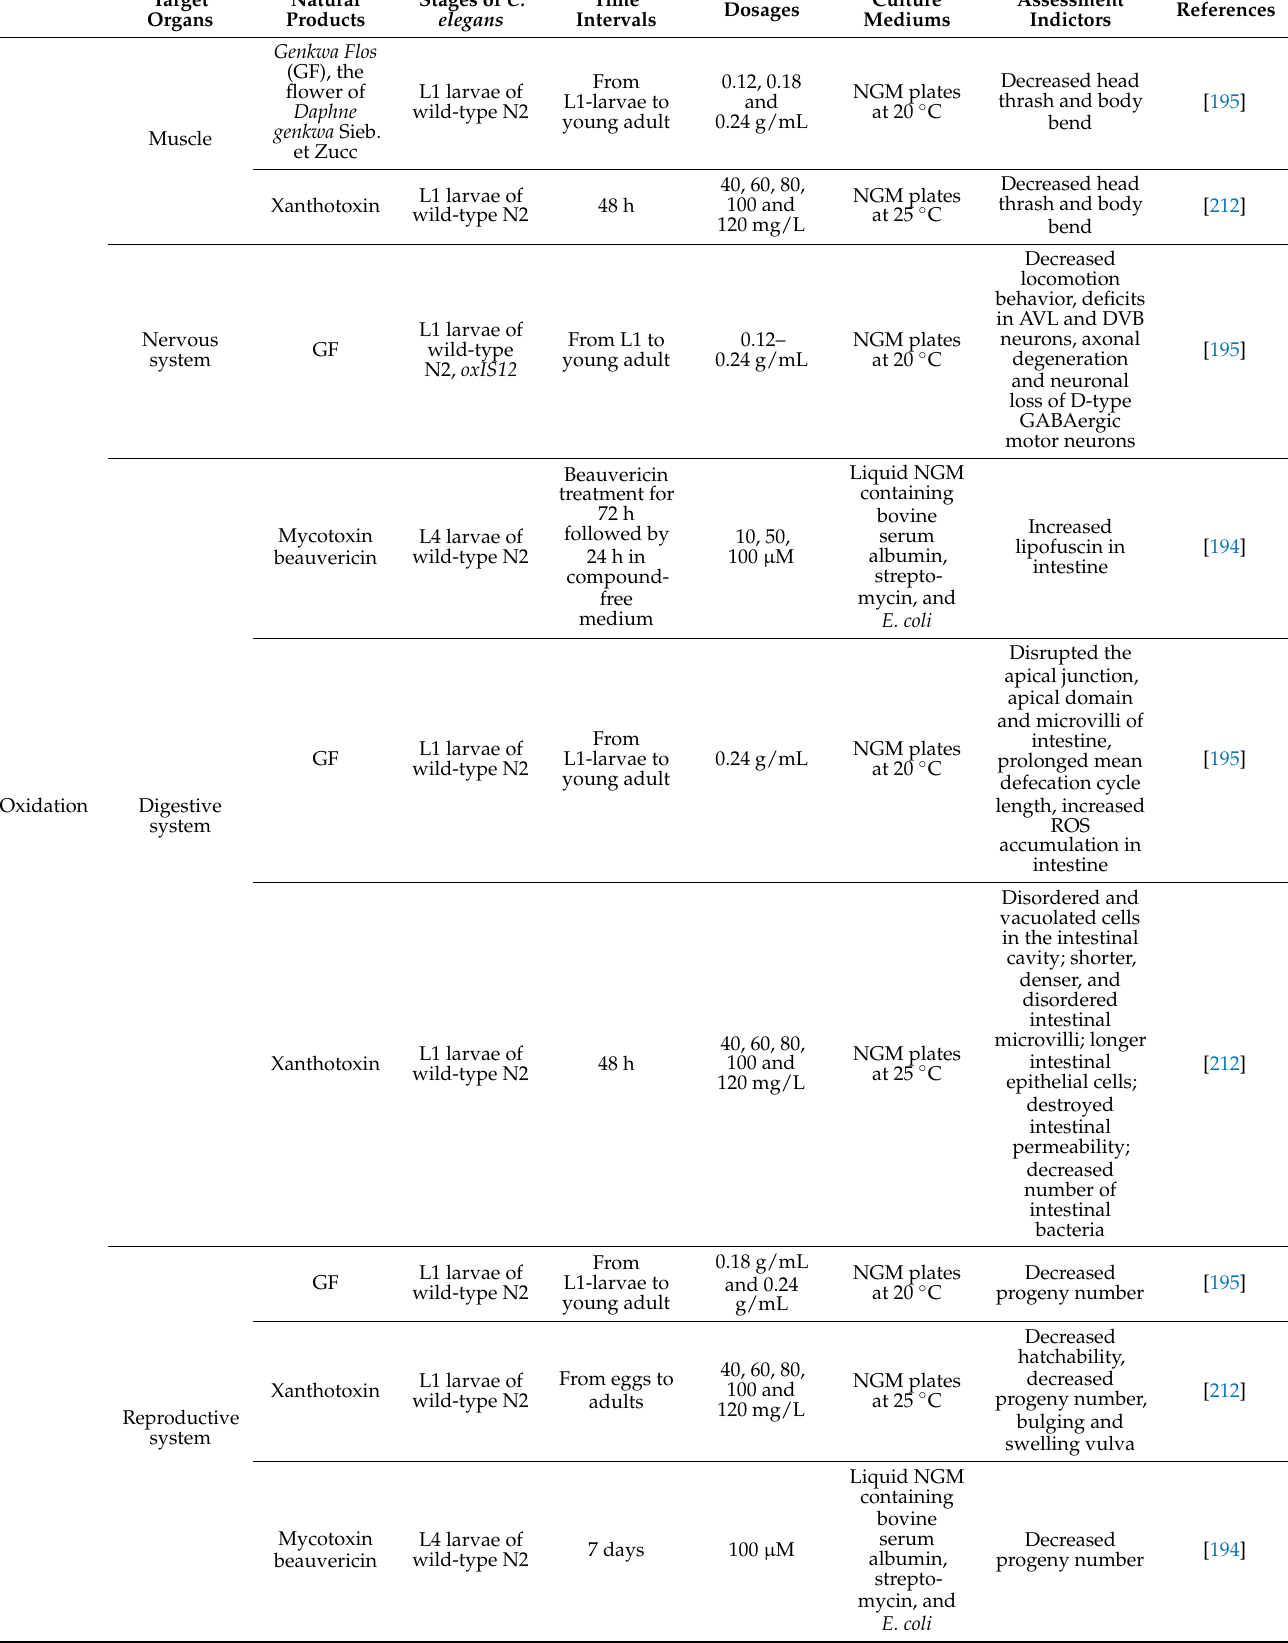
Table 2. Oxidation and antioxidation of natural products in the target organs of C. elegans